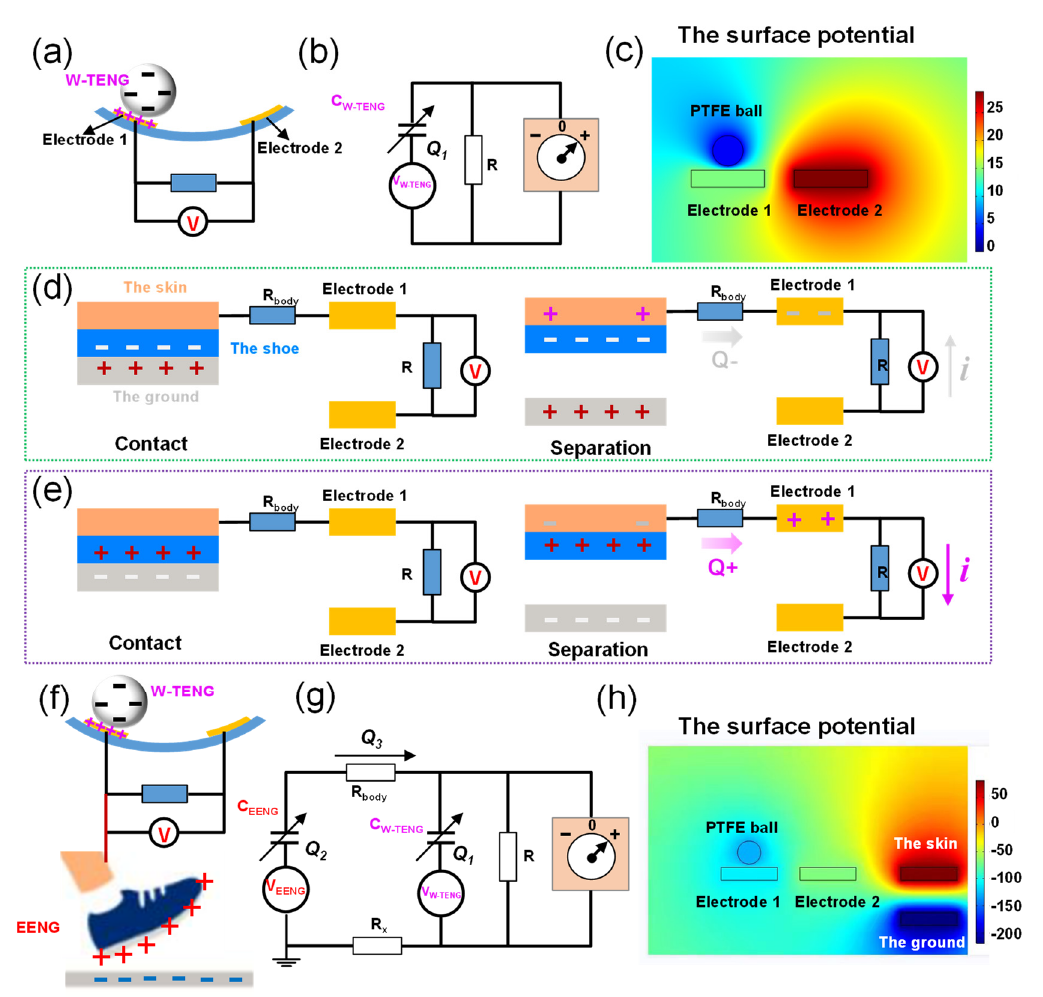
Figure 2. Analysis of the working principle: ( a ) the working principle of the W − TENG; ( b ) the circuit equivalent model of the W − TENG; ( c ) the simulation result of the output of W − TENG; ( d , e ) the analysis of charge-transfer direction for different materials; ( f ) the working principle of the C − ENG; ( g ) the circuit equivalent model of the C − ENG; and ( h ) the simulation result of the output of C − ENG.